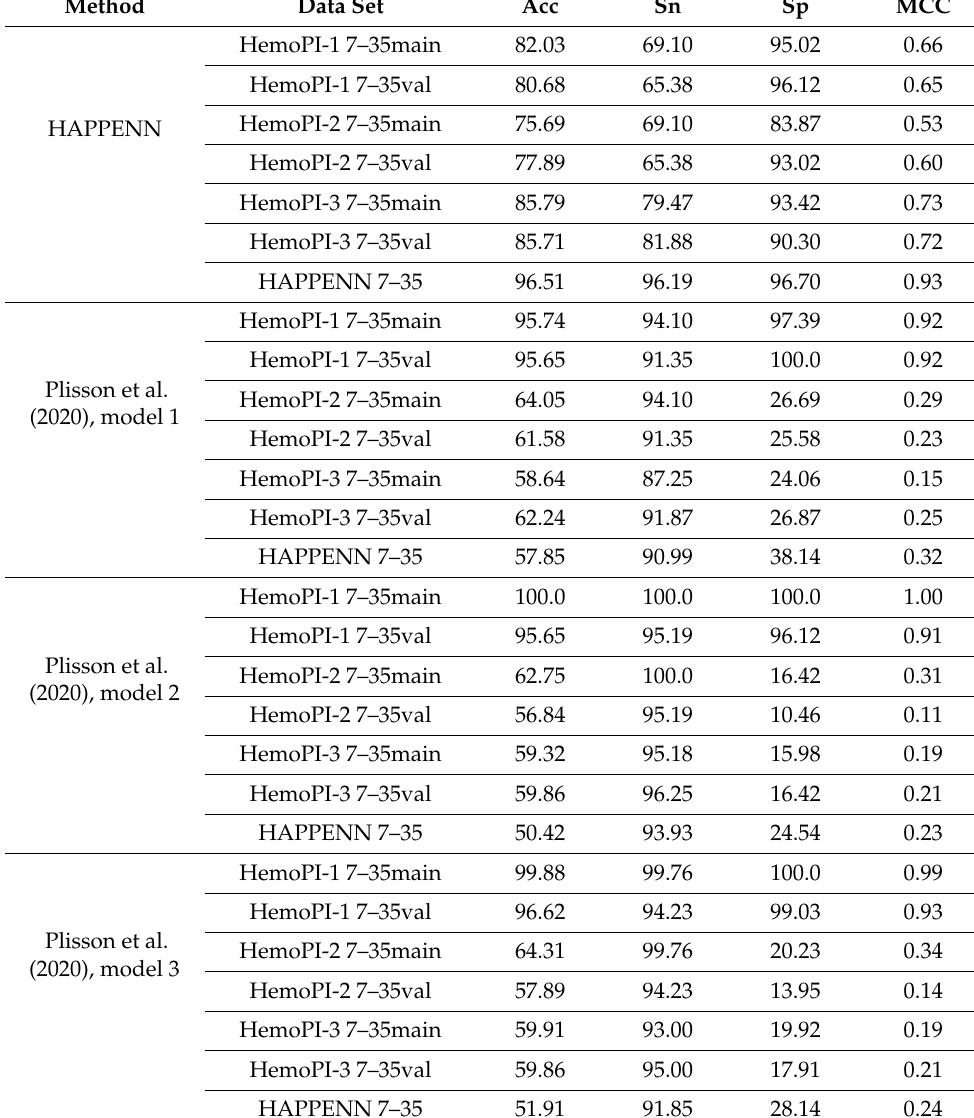
Table 4. Test results for state-of-the-art predictors based on seven data sets. HemoPI-1 7–35main, HemoPI-1 7–35val, HemoPI-2 7–35main, HemoPI-2 7–35val, HemoPI-3 7–35main, HemoPI-3 7–35val, and HAPPENN 7–35 data sets were employed to challenge the main